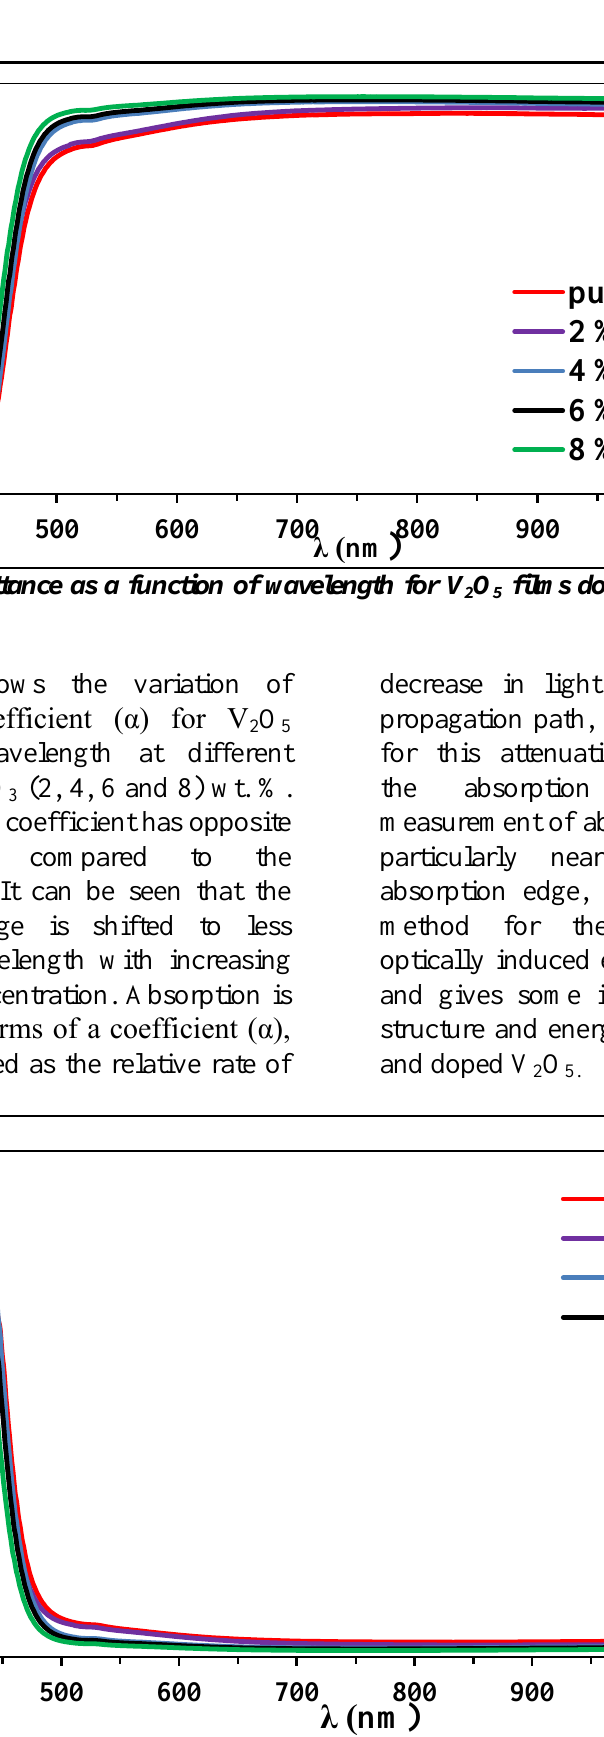
O films doped with (2, 4, 6, 2 5